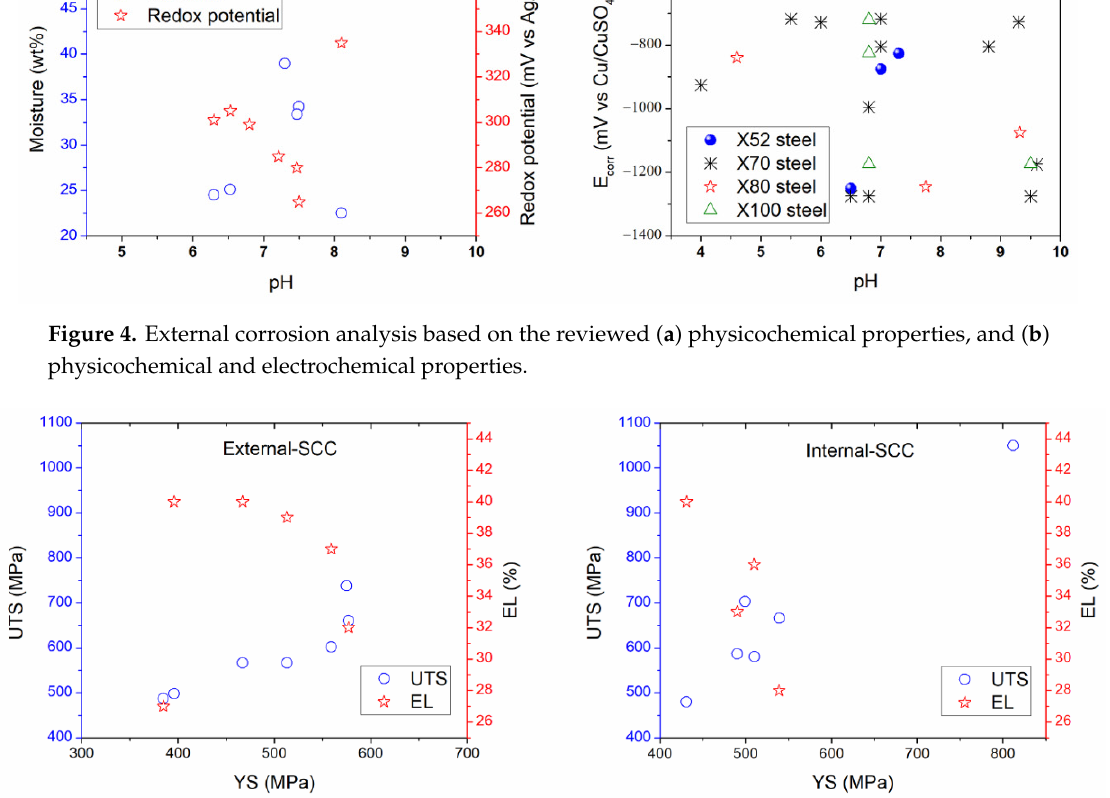
Figure 5. Comparison of the external- and internal-stress corrosion cracking ((E-SCC) and (I-SCC)) in respect to mechanical properties based on the reviewed experimental data.